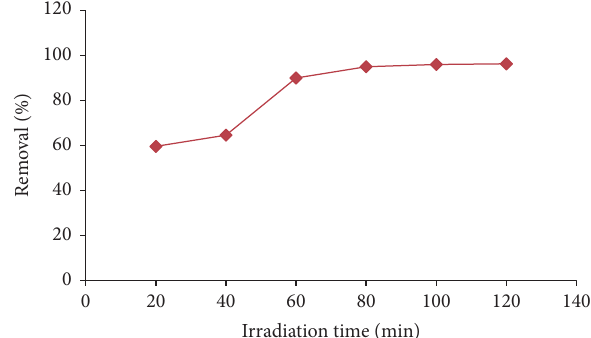
Figure 7: Effect of irradiation time on the degradation of furfural. TiO 2 /GAC composite dosage: 2.5 g/L, initial pH: 10, and initial furfural concentration: 300